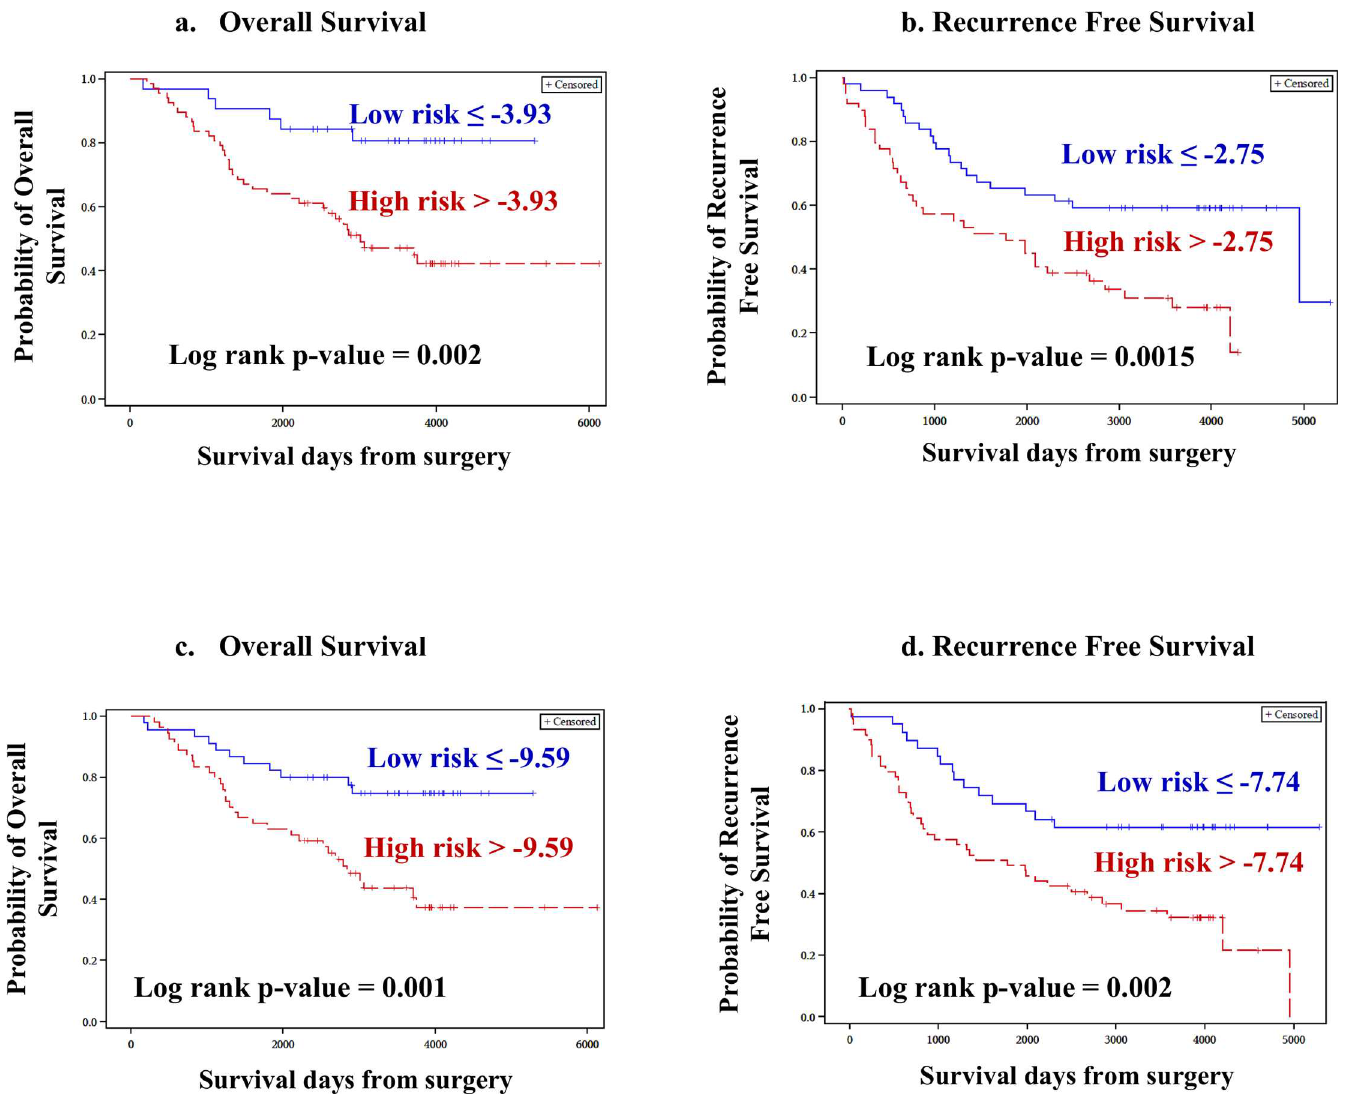
Fig 2. Kaplan–Meier plotsfor case–control approach. Kaplan-Meier plots for riskscores were constructedto determinesurvival differences between low–riskand high–riskgroups. Significant survivaldifferences existed between the two riskgroups, as indicatedby the log–rankp–values. (A) OS for CC approach.(B) RFS for CC approach.(C) OS for CO approachand (D) RFS for CO approach.In all these approaches, patientsbelongingto high–riskgroup showed poor OS and